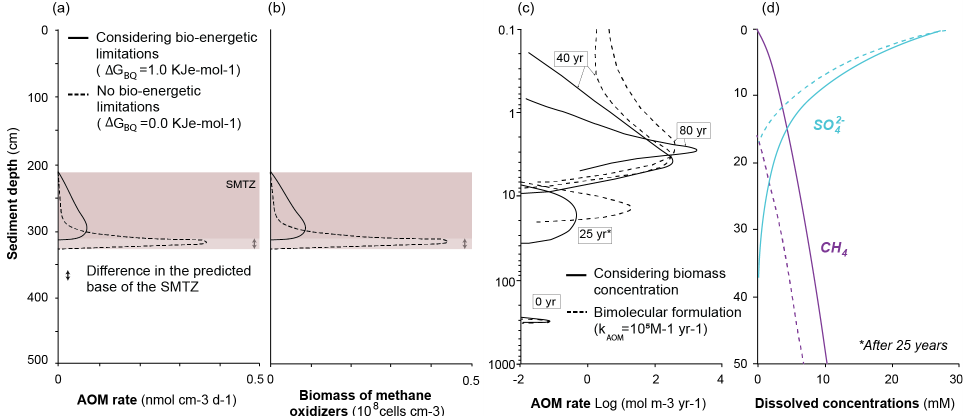
Figure 7. Left panels show the effect of thermodynamic limitations on ( a ) AOM rates estimates and ( b ) anaerobic methane-oxidizing biomass concentration in a diffusion-dominated system. Data adapted from [41]. Right panels show the effect of biomass concentration on ( c ) AOM rates estimates along time and ( d ) the corresponding profiles of sulfate ( SO 2 − ) and methane ( CH 4 ) dissolved in 4 pore-water with depth after 25 years of simulation. Data adapted from [43]. For comparison purposes, dashed lines show the values predicted when disregarding the influence of biomass dynamics on net biomass growth and the AOM rate. Note that the units of ∆ G BQ are expressed in terms of mole electron donor consumed. See Section 3.2 for details on AOM rate